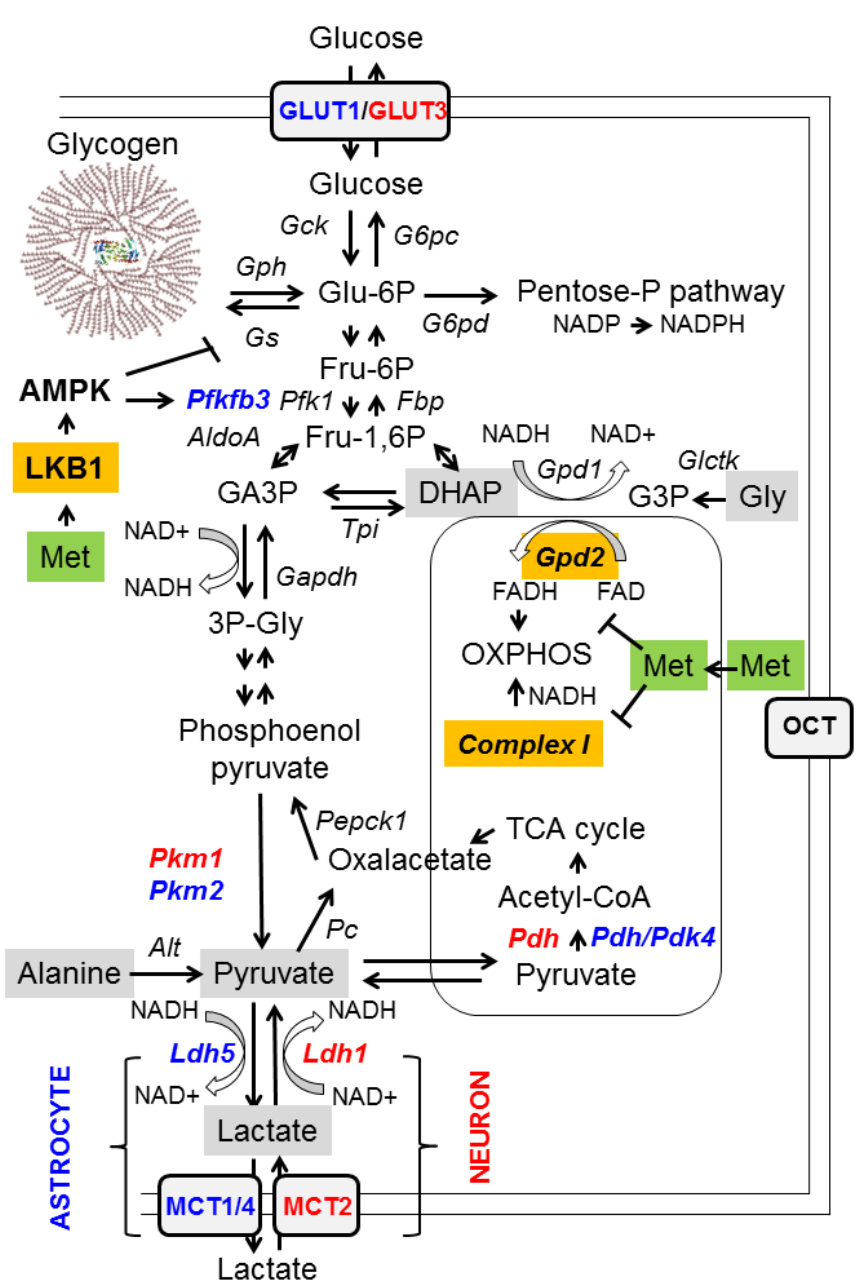
Figure 1. Metabolic pathways affected by metformin. A diagram of the main pathways related to glycolysis and gluconeogenesis is depicted. Gluconeogenic substrates are highlighted in grey, and enzymes directly affected by metformin are highlighted in orange. Specific enzyme isoforms present in neurons are in red, and those present in astrocytes are in blue. See text for details. AldoA: aldolase; Alt: Alanine aminotransferase; AMPK: AMP-activated protein kinase; NADH: ubiquinone oxidoreductase; Fbp: fructose bisphosphatase; Gapdh: glyceraldehyde-3P dehydrogenase; G6pc: glucose 6-phosphatase; G6pd: glucose-6P dehydrogenase; Gck: glucokinase; Glctk: glycerate kinase; GLUT: glucose transporter; Gpd: glycerol-3P dehydrogenase; Gph: glycogen phosphorylase; Gs: glycogen synthase; Ldh: lactate dehydrogenase; LKB1: liver protein kinase; MCT: monocarboxylic transporter; OCT: organic cation transporter; Pc: pyruvate carboxylase; Pdh: pyruvate dehydrogenase; Pdk: pyruvate dehydrogenase kinase; Pepck1: phosphoenolpyruvate carboxykinase; Pfk: phosphofructokinase; Pfkfb3:phosphofructokinase 2,6-bisphosphatase; Pkm: pyruvate kinase; TCA cycle: tricarboxylic acid cycle; Tpi: triosephosphate isomerase.